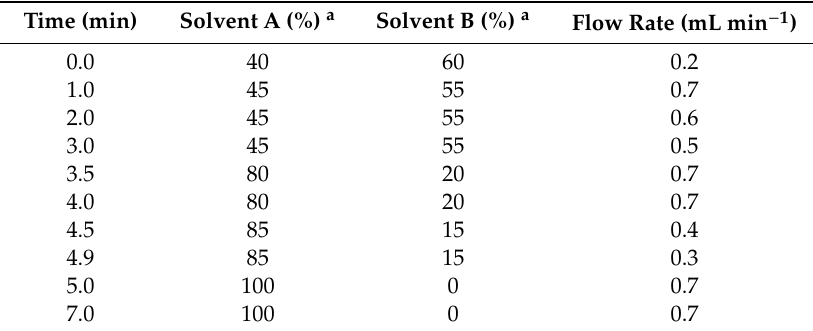
Table 5. The gradient elution program and the mobile phase flow